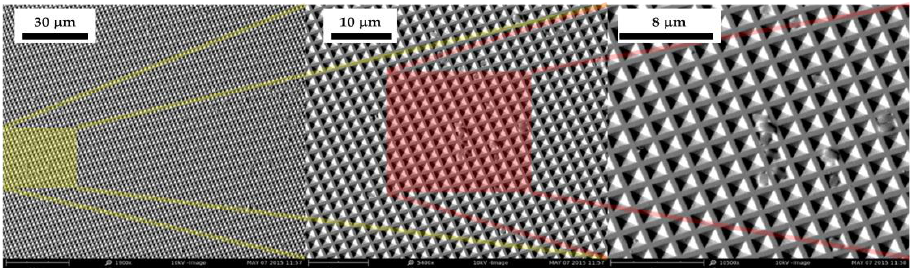
Figure 7. SEM pictures of the SERS sensor contaminated with SBA after the whole deposition-rinsing procedure. The coloured areas represent areas zoomed at different